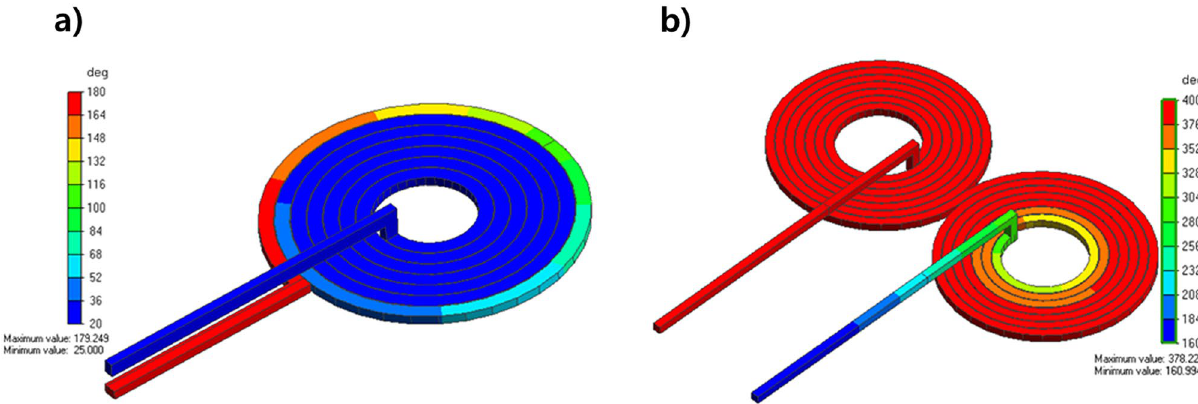
Figure 8. Comparison of thermal analysis of the designed: ( a ) circular coil; and ( b ) figure 8-shaped